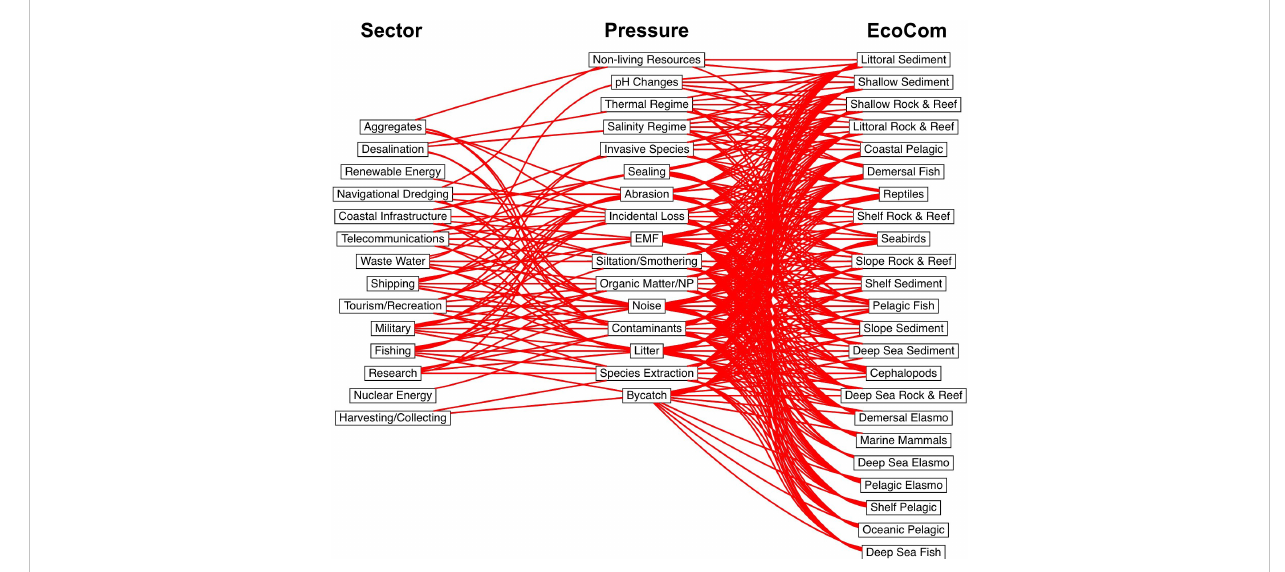
FIGURE 2 Horrendogram, illustrating the complexity of the linkage framework. All sectors, pressures and ecological components assessed in the case study area are indicated. Red lines indicate connections. EMF = Electromagnetic fi eld. Elasmo = elasmobranchs. Interactive version can be found at https://ariccir.shinyapps.io/maio_2022/.